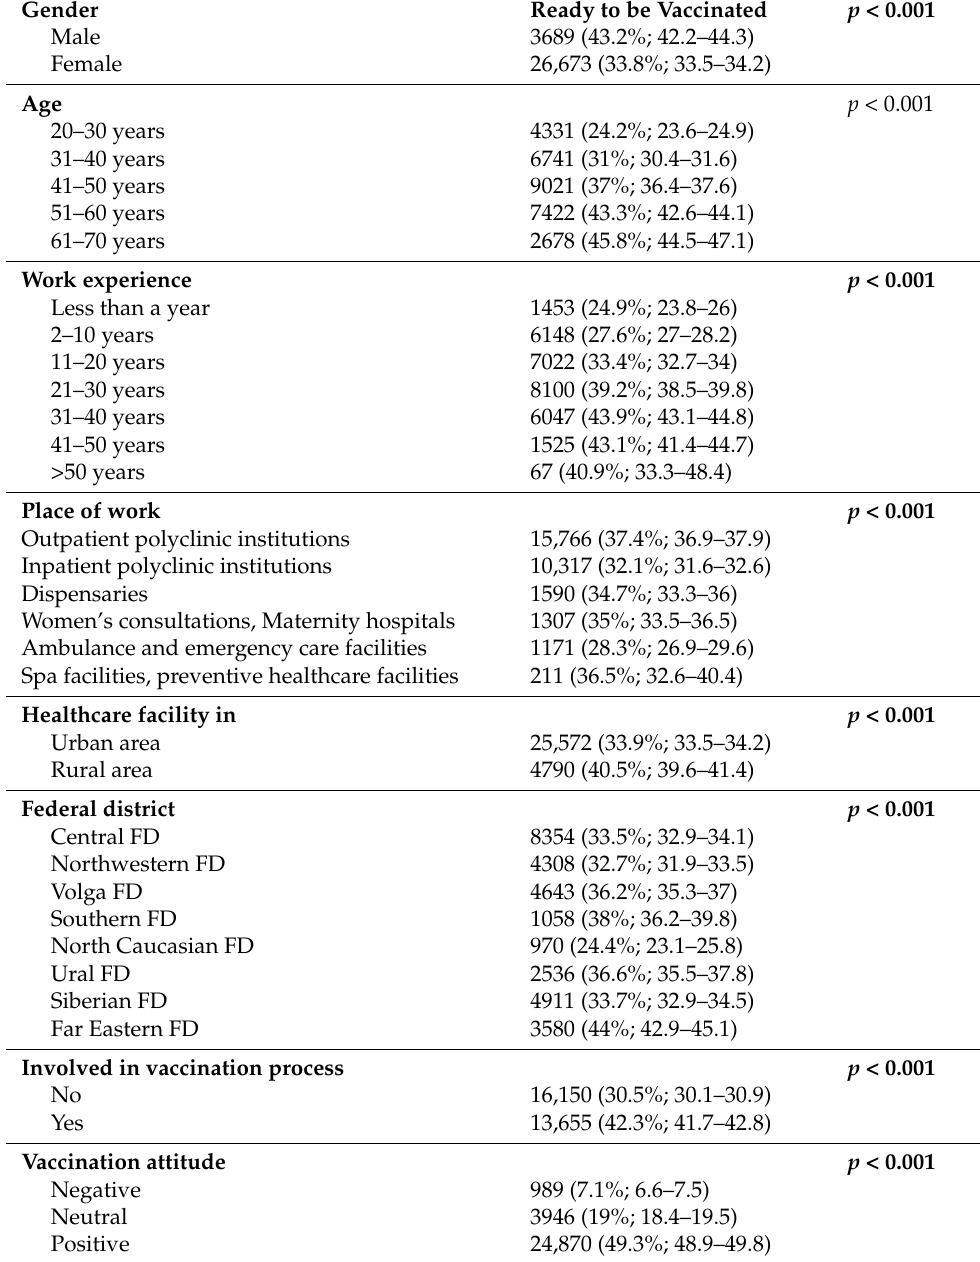
Table A1. Proportion of healthcare workers ready to be vaccinated against